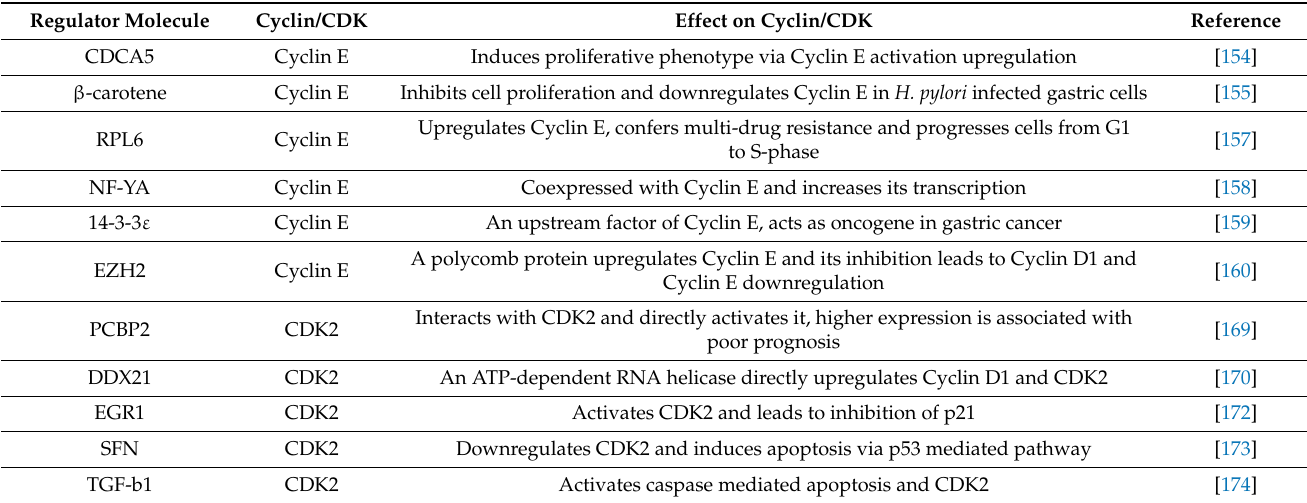
Table 5. The molecules acting as regulators of Cyclin E-A/CDK2 axis in gastric cancer.